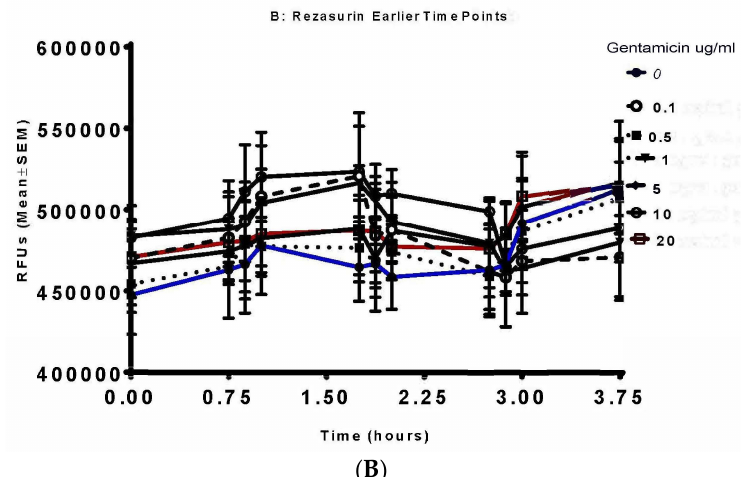
Figure 11. Cellular metabolic activity of M. avium with gentamicin treatment at time zero and 90 h. ( A ) Increased activity after 90 h was significant for 0, 0.5, and 20 µg/mL at * p < 0.05 and for 5 µg/mL at ** p < 0.01 according to two-tailed, paired T -test analysis when comparing to the initial 0-minute time point, n = 3. ( B ) The cyclic nature of the metabolism of M. avium over the course of the study in the presence and absence of the dose escalation of gentamicin. The blue line is without gentamicin, the red line is with the 20 µg/mL gentamicin dose.